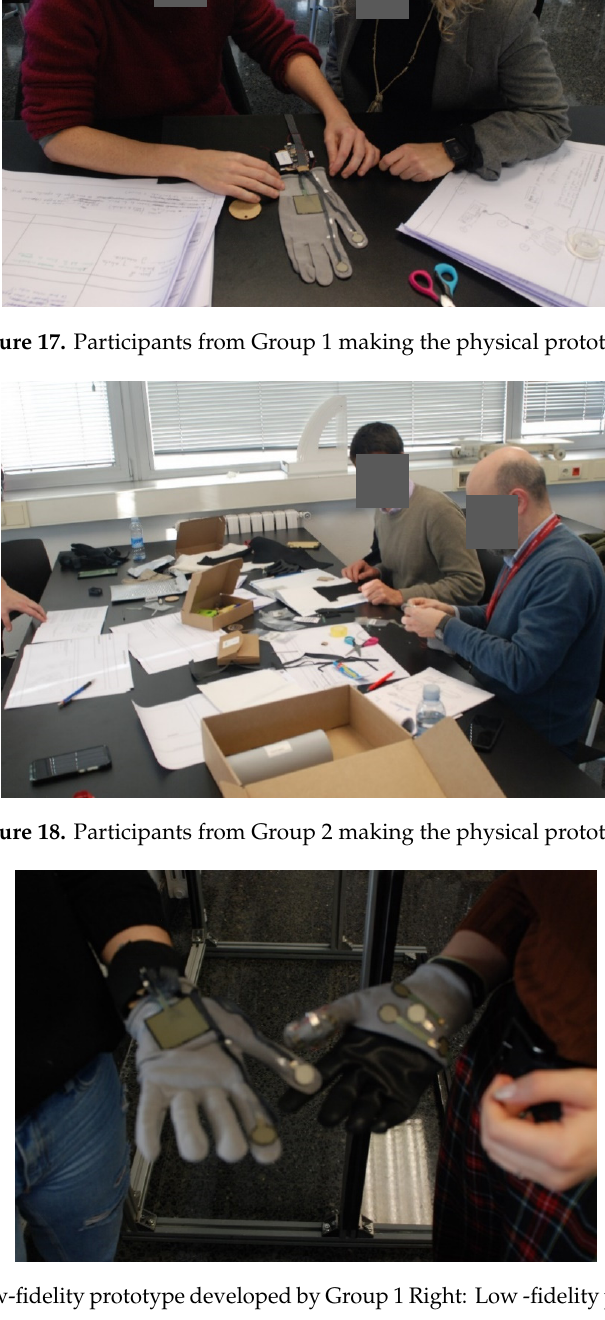
Figure 19. Left: Low-fidelity prototype developed by Group 1 Right: Low -fidelity prototype developed by Group 2.